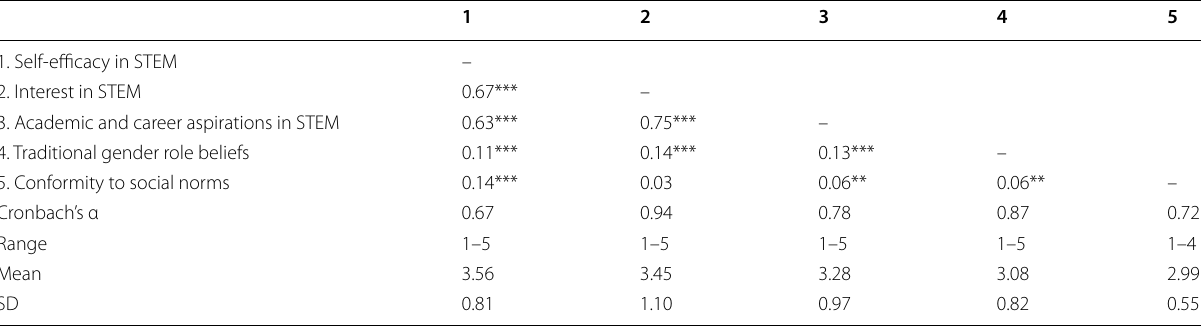
Table 2 Descriptive statistics and correlations of study